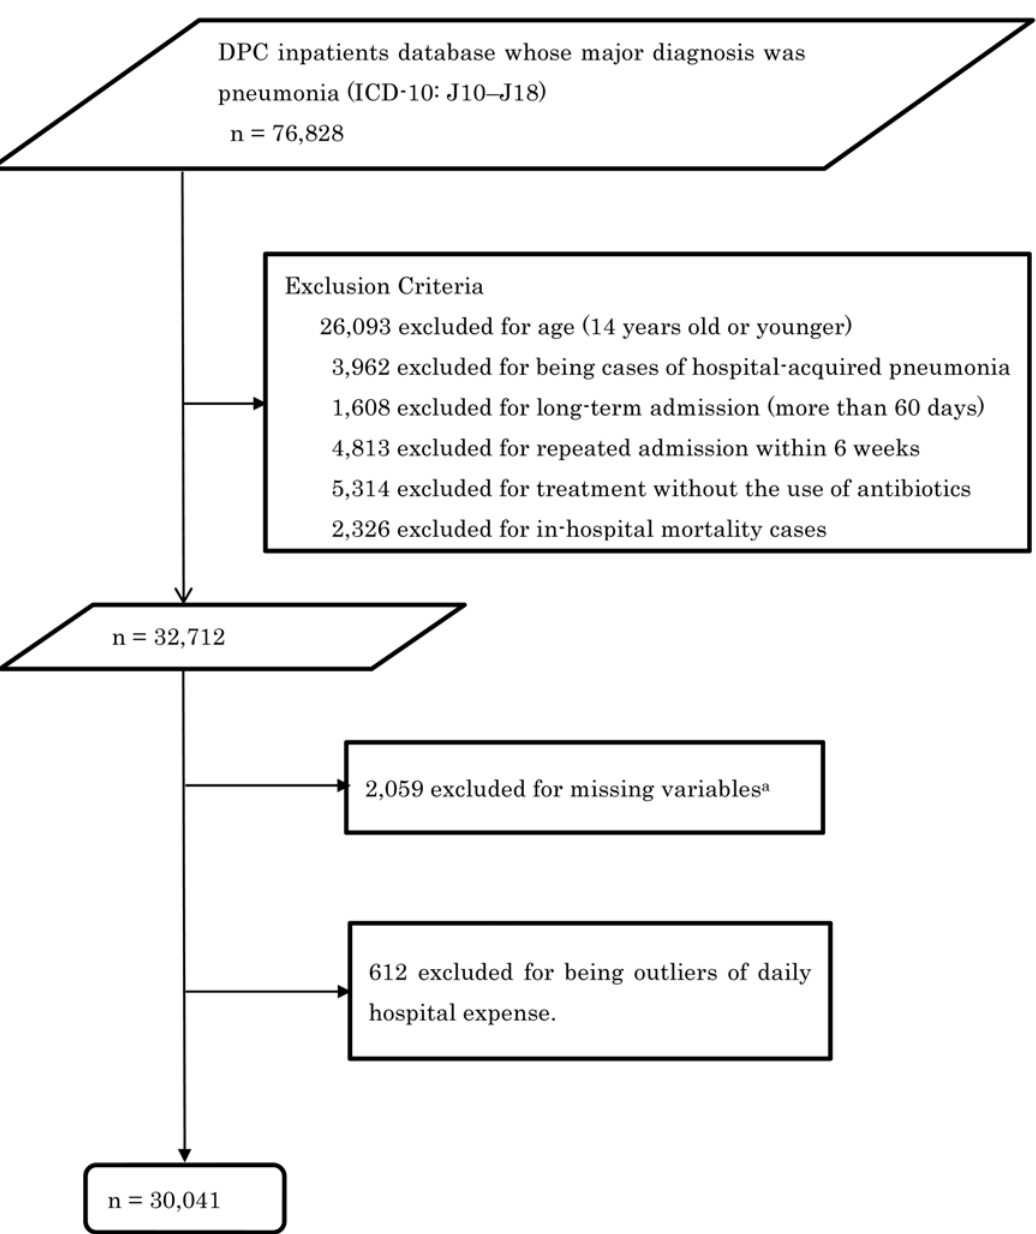
Fig 1. Selection of inpatients with community-acquired pneumonia from the Diagnostic Procedure Combination (DPC) database. a Missing variables included blood urea nitrogen or dehydration, respiratory state, orientation, blood pressure, number of beds, number of physician, and number of